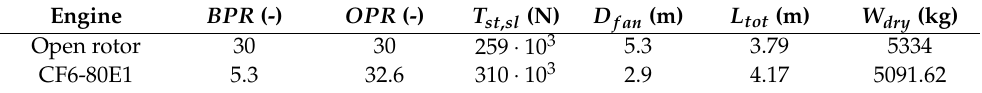
Table 2. Engine design parameters (CF6-80E1 data from